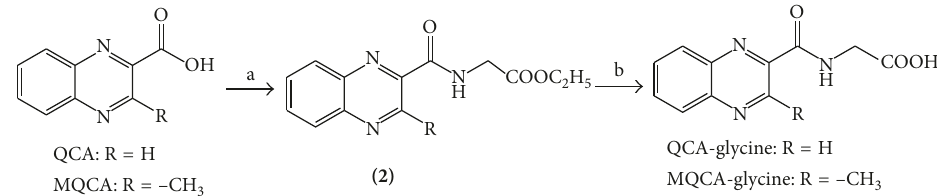
Scheme 1: Synthesis route of QCA-glycine and MQCA-glycine. Reagents and conditions: (a) glycine ethyl ester, DCC, DMAP, and DCM at room temperature for 4h; (b) (1) 1 M NaOH at room temperature for 2h and (2)